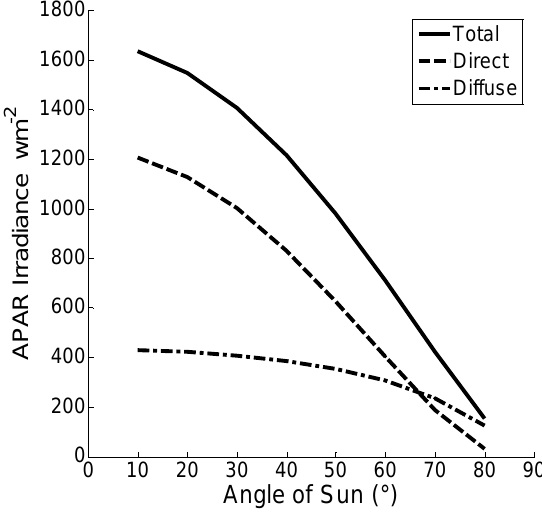
Figure 6. Diurnal variation of Absorbed Photosynthetically Active Radiation irradiance (APAR) (w m − 2 ). Data were collected for a single day during June 2004 depicting direct, diffuse, and total irradiance for a partly cloudy sky.